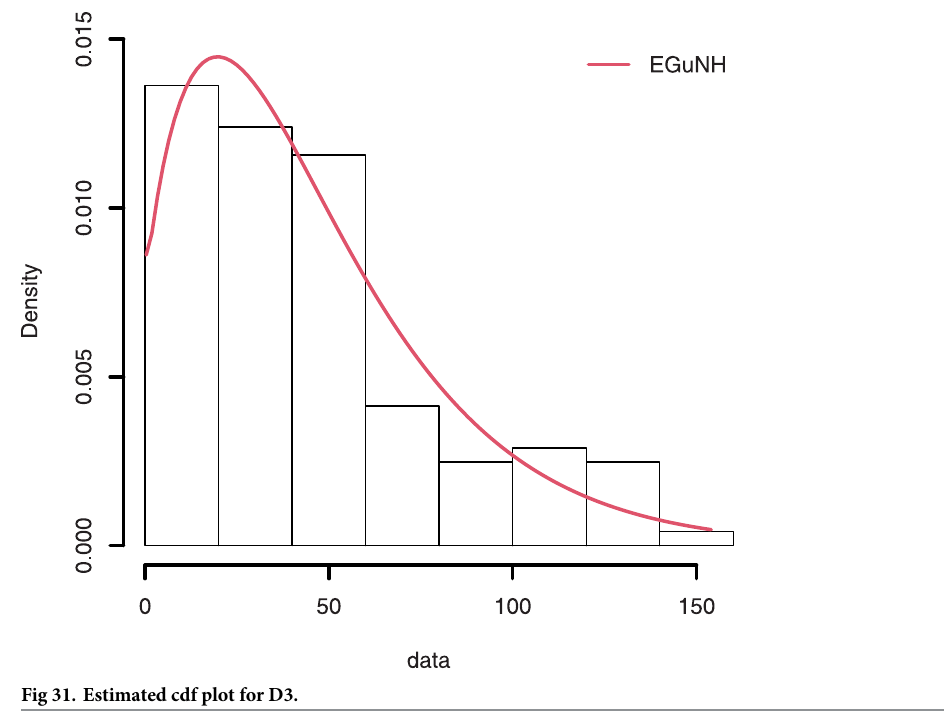
Fig 31. Estimated cdf plot for D3.